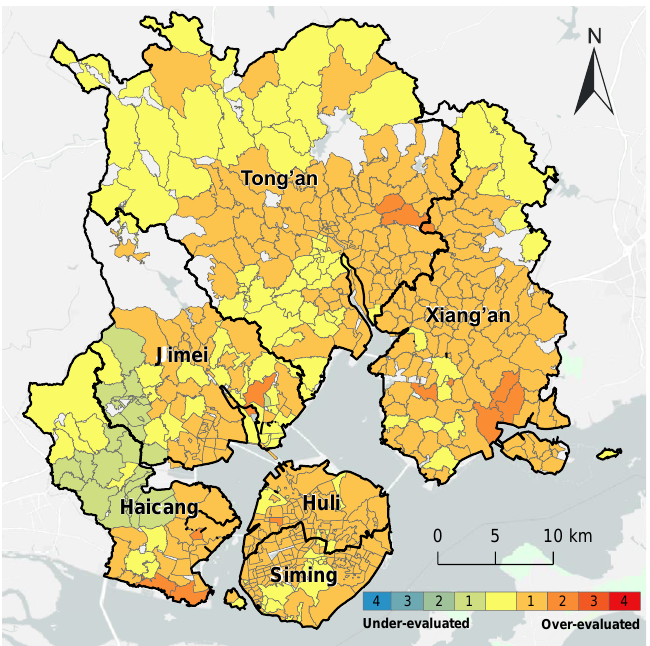
Figure 8. Comparison of the spatial accessibility of surgery service with the overall spatial accessibility in Xiamen City.